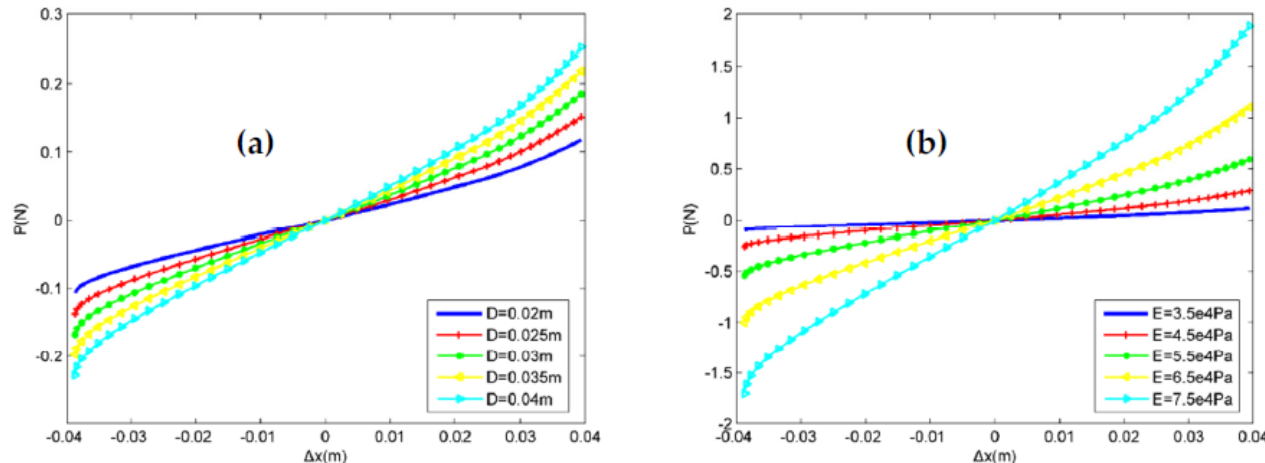
Figure 6. Comparison of spring recovery force curves under different parameters. ( a ) E = 3.5 × 10 4 Pa; ( b ) D = 0.02 m. Table 1. The stiffness coefficient and initial load.